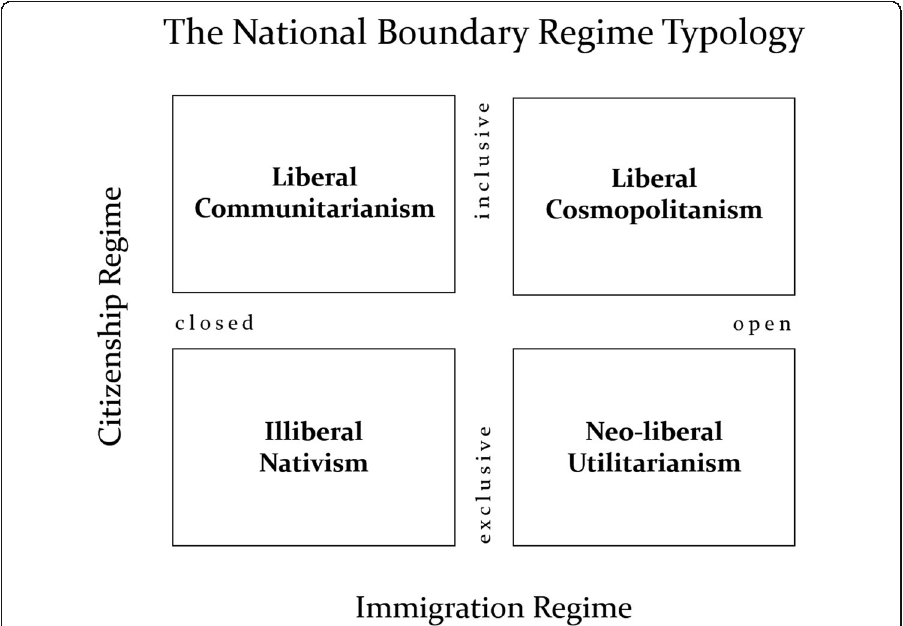
Fig. 1 The National Boundary Regime